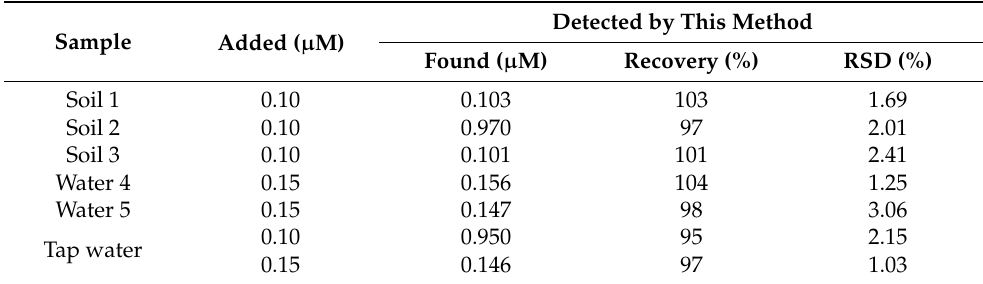
Table 3. The MIIP/Fe 3 O 4 @SiO 2 /MCPE sensor applied to UO 22+ analysis and determination in actual samples ( n =